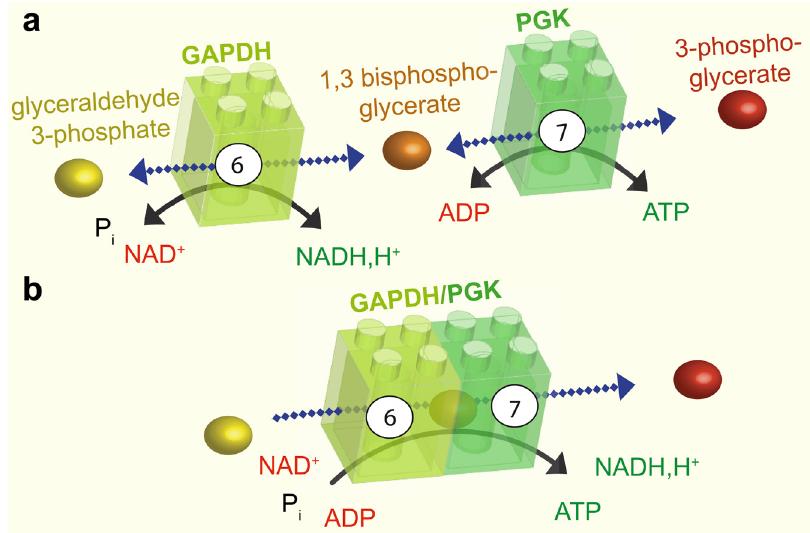
Figure 2. Substrate channeling. a : The sixth step of glycolysis is catalysed by GAPDH, which adds a phosphate group at position one of glyceraldehyde 3-phosphate to produce the intermediate 1,3 bisphosphoglycerate and NADH, H + . This reaction is reversible. The intermediate product and ADP are then transformed by PGK in the seventh step of glycolysis, to produce 3-phosphoglycerate and ATP. b : GAPDH and PGK can associate. In this case, the intermediate product, 1,3 bisphosphoglycerate, is channeled between the two enzymes resulting in a unidirectional reaction. GAPDH, glyceraldehyde 3-phosphate dehydrogenase; P , inorganic phosphate; NADH,H + nicotinamide i adenine dinucleotide; ADP, adenosine diphosphate; ATP, adenosine 5’-triphosphate; PGK, phosphoglycerate